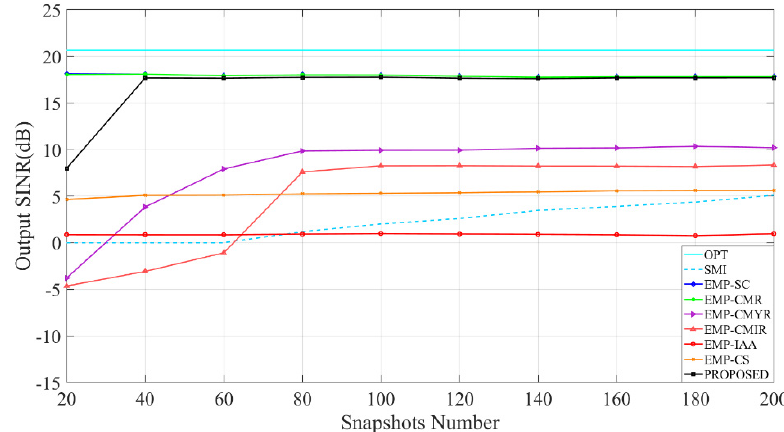
Figure 5. Analysis of the impact of snapshots number on output SINR.